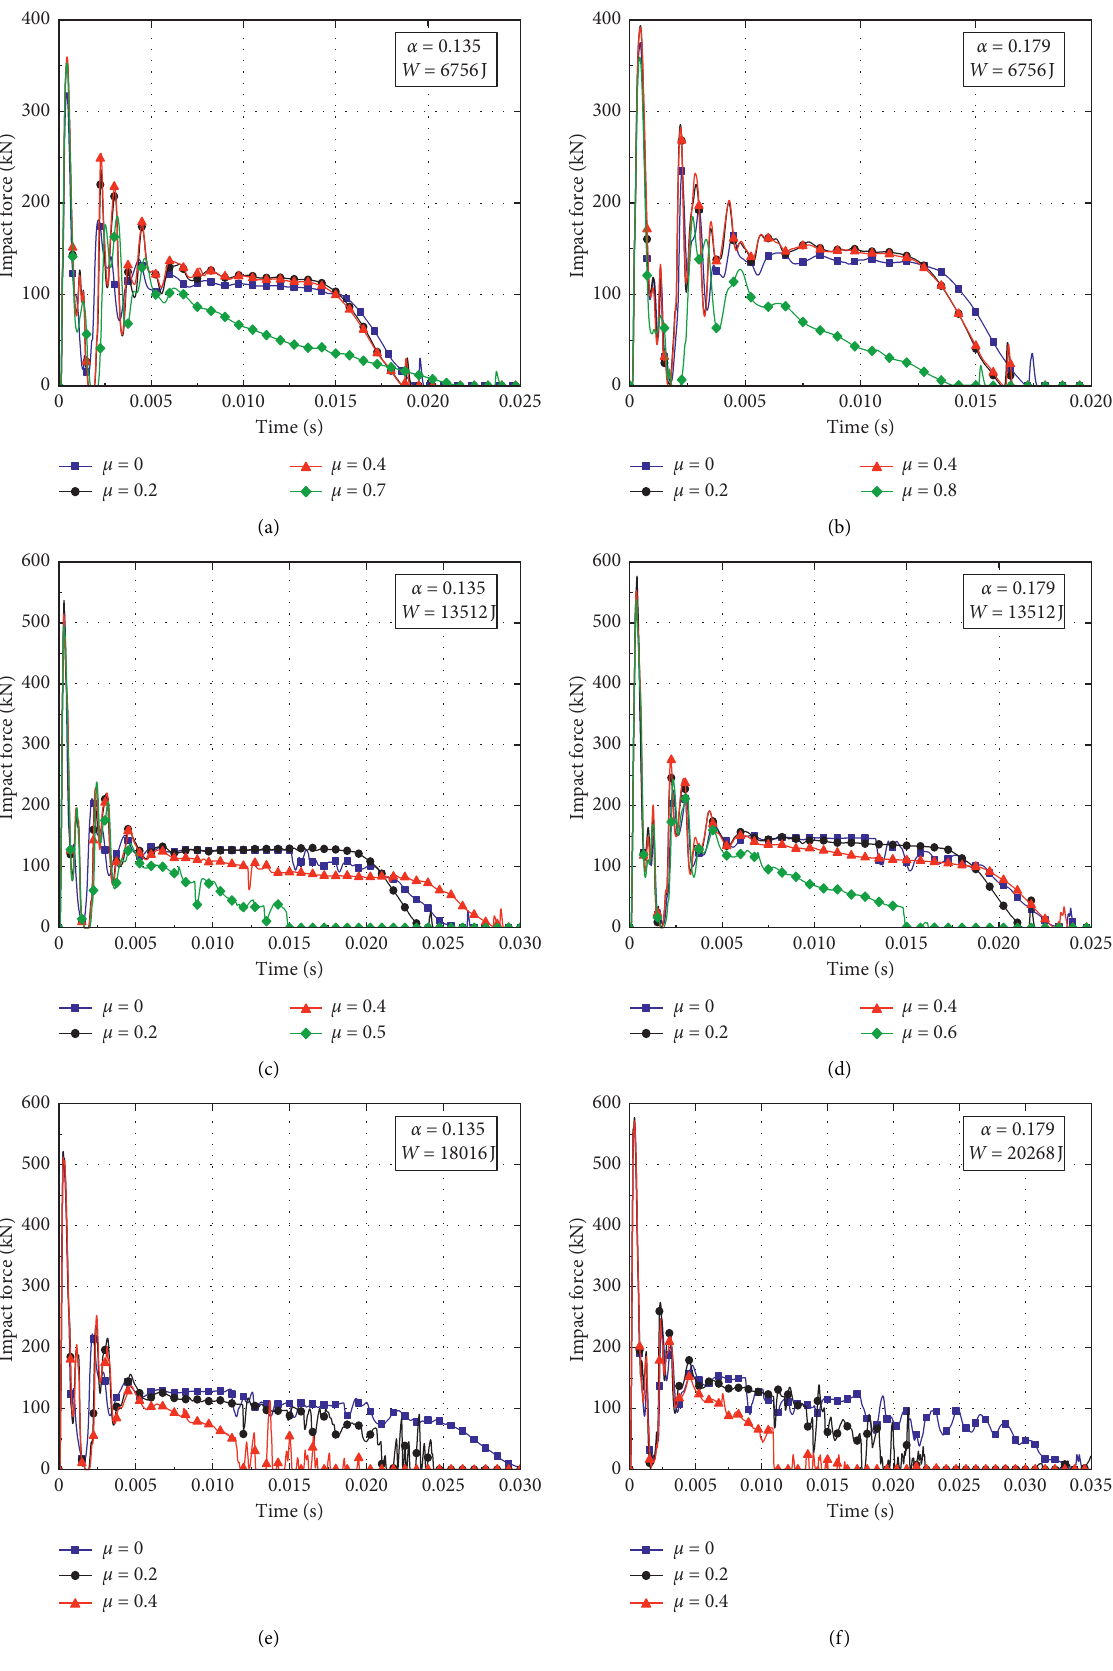
Figure 4: Impact force-time histories of CFST members with different parameters. (a) A1 series. (b) B1 series. (c) A2 series. (d) B2 series. (e) A3 series. (f) B3